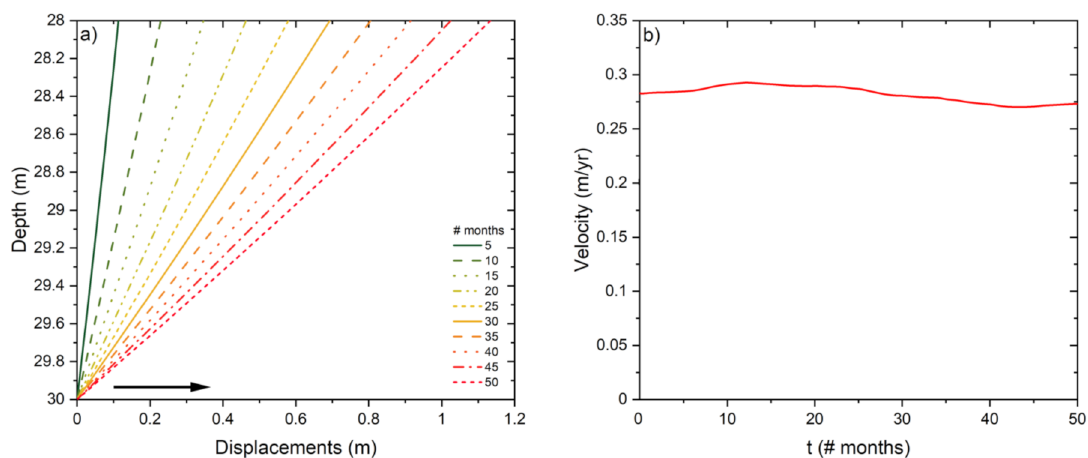
Figure 9. ( a ) Variation in time of profiles of displacements in the shear horizon and ( b ) variation of velocity with